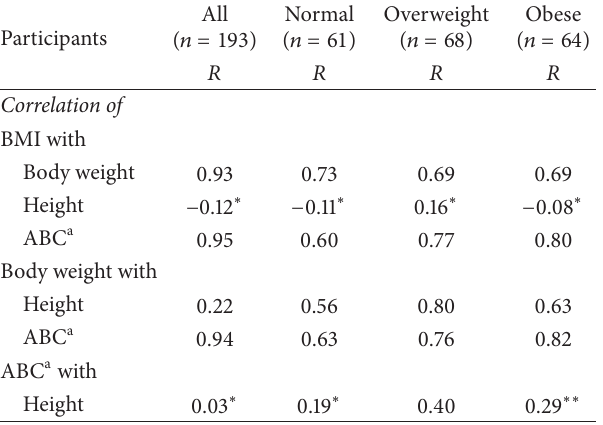
Table 3: Spearman Rank intercorrelations between BMI, body weight, height, and average body circumference (ABC).